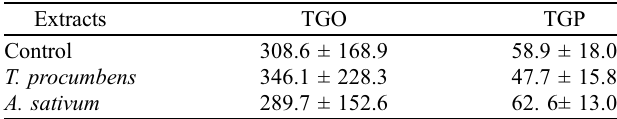
Each result is mean ± SD of TGO and TGP (UI) for three or six mice samples.